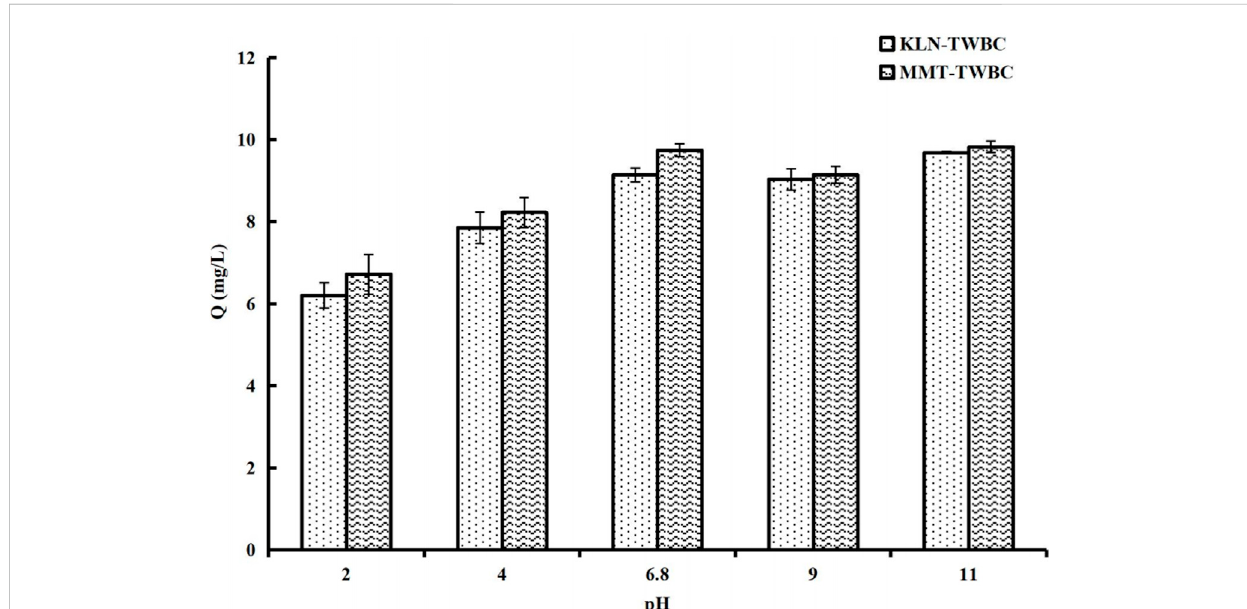
FIGURE 3 Effect of pH on MB adsorption for KLN-TWBC and MMT-TWBC (Initial MB concentration of 20 mg/L, contact time 48 h, temperature 25 ° C ± 0.5 ° C, adsorbent dose 2 g/L, and MB solution 25 mL). KLN-TWBC, kaolinite modi fi ed tea waste biochar; MMT-TWBC, montmorillonite modi fi ed tea waste biochar. Error bars represent the standard deviations of triplicate